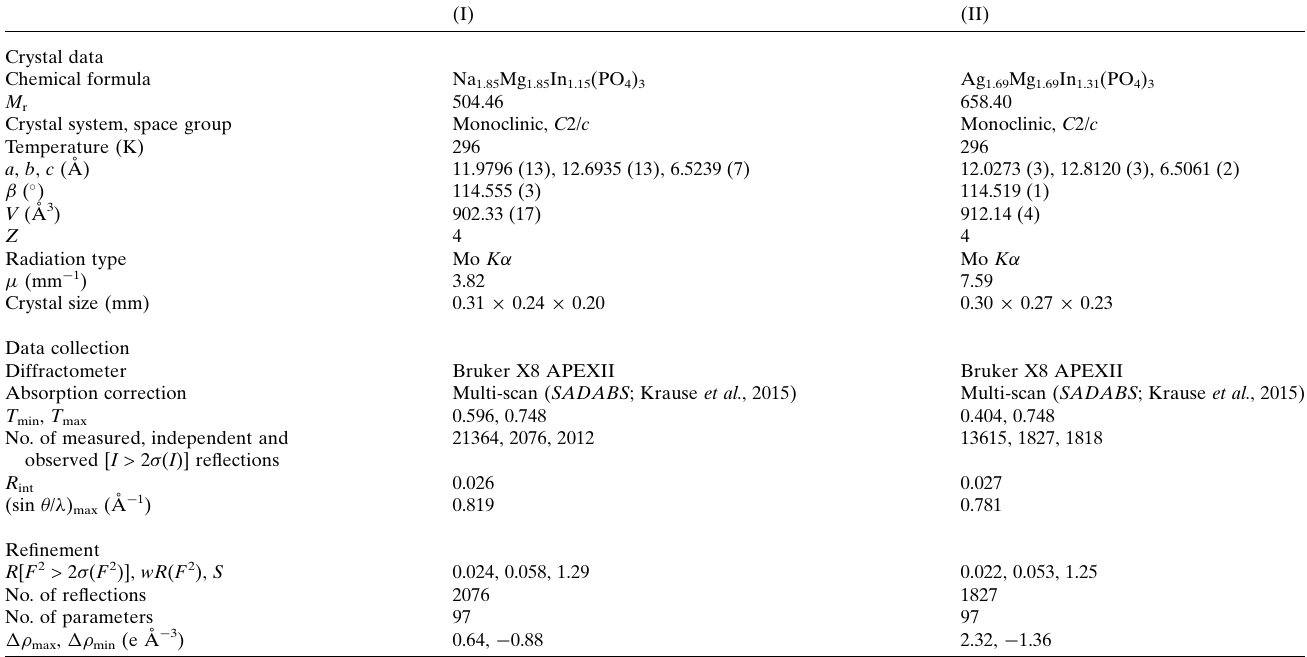
Table 1 Experimental details.